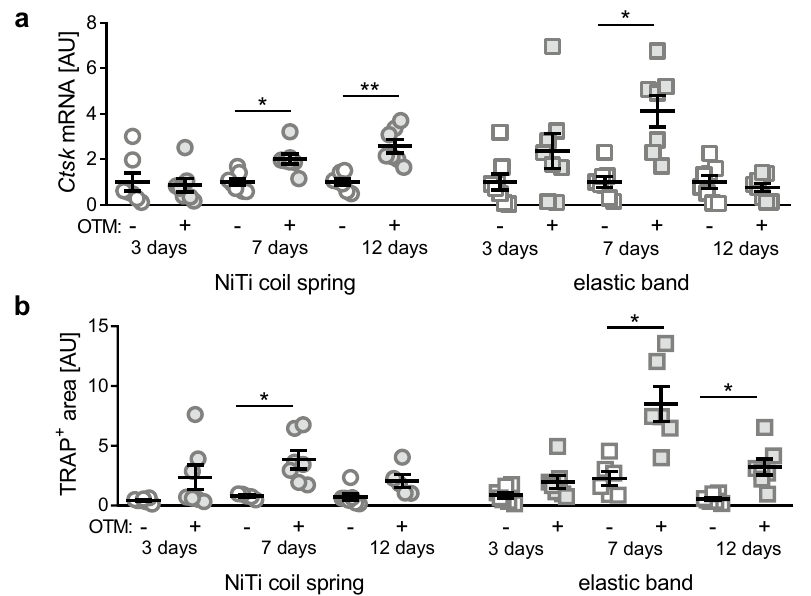
Figure 3. Relative Ctsk gene expression ( a ) and relative TRAP + area corresponding to osteoclastogenesis ( b ) after three, seven or 12 days of OTM with a NiTi coil spring or an elastic band compared to the untreated contralateral jaw side. [AU] arbitrary units. * p ≤ 0.05, ** p ≤ 0.01.